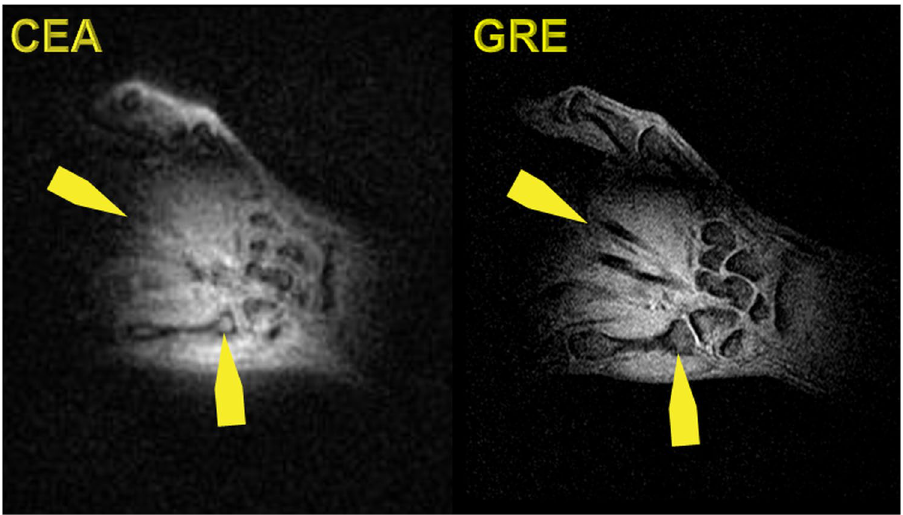
Figure 8. Coronal slice from the 3D CEA MR image of the healthy volunteer wrist (left), and GRE image as the anatomical reference (right).